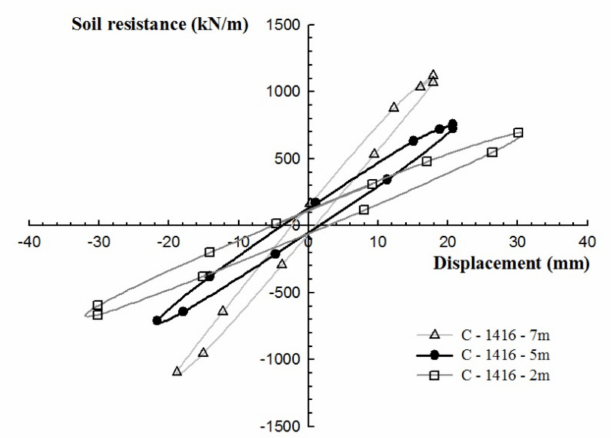
Figure 9. Experimental cyclic p-y curve for each depth when N cycle =